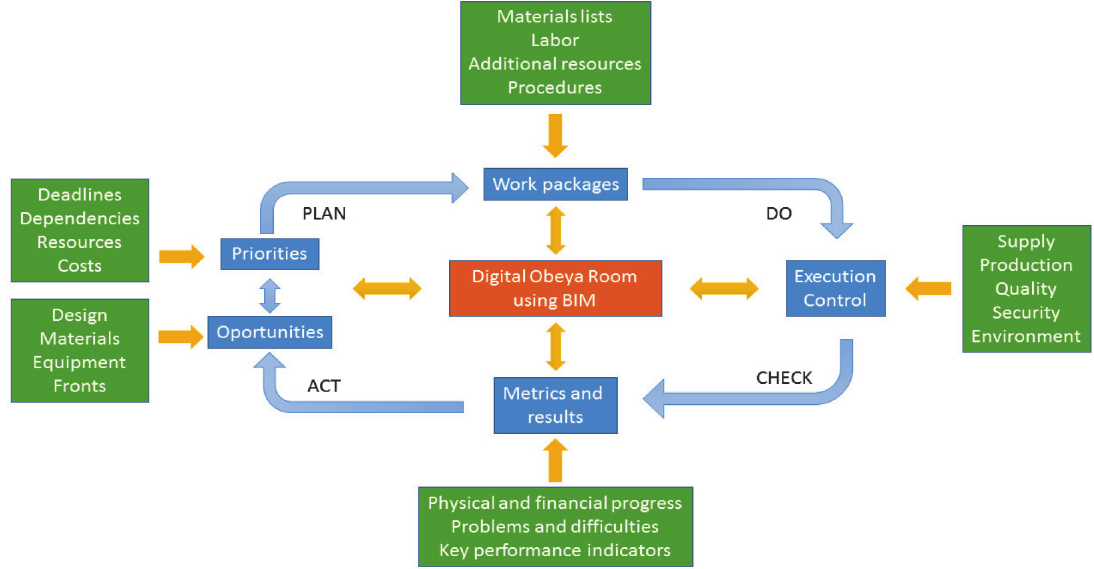
Figure 1. Framework for integration of Lean Thinking to BIM in the PDCA of the nD visual